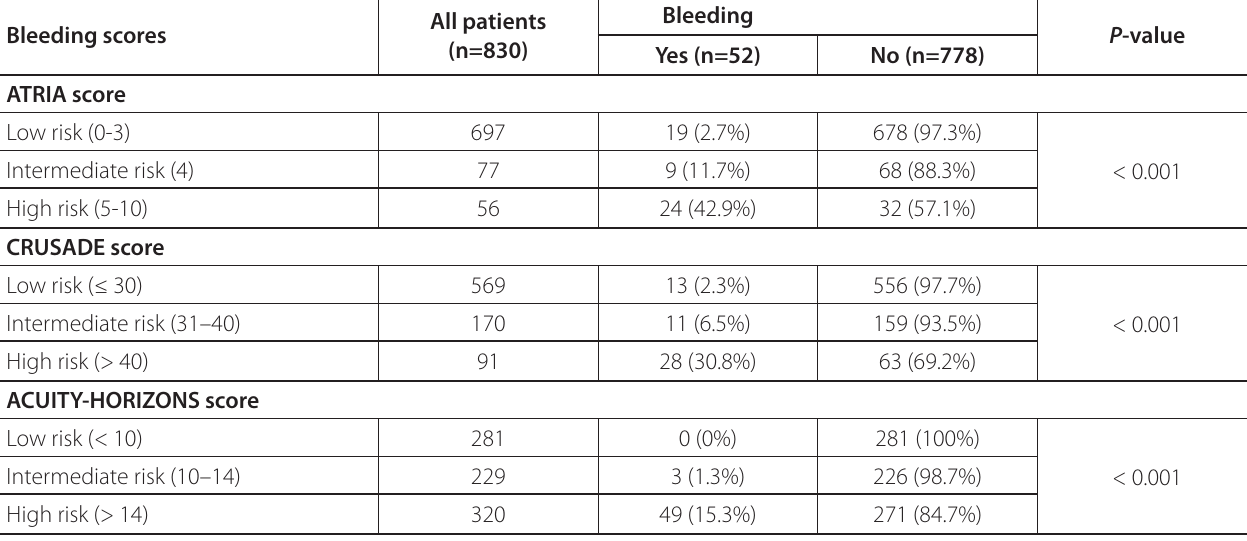
Table 3 . ATRIA, CRUSADE, and ACUITY HORIZONS bleeding scores subcategorized to low, intermediate, and high risk. All patients Bleeding scores